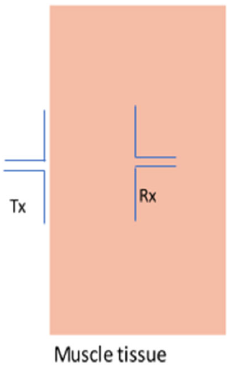
Figure 2. Propagation of the wave from lossy ‐ to ‐ lossy medium: fat to muscle.